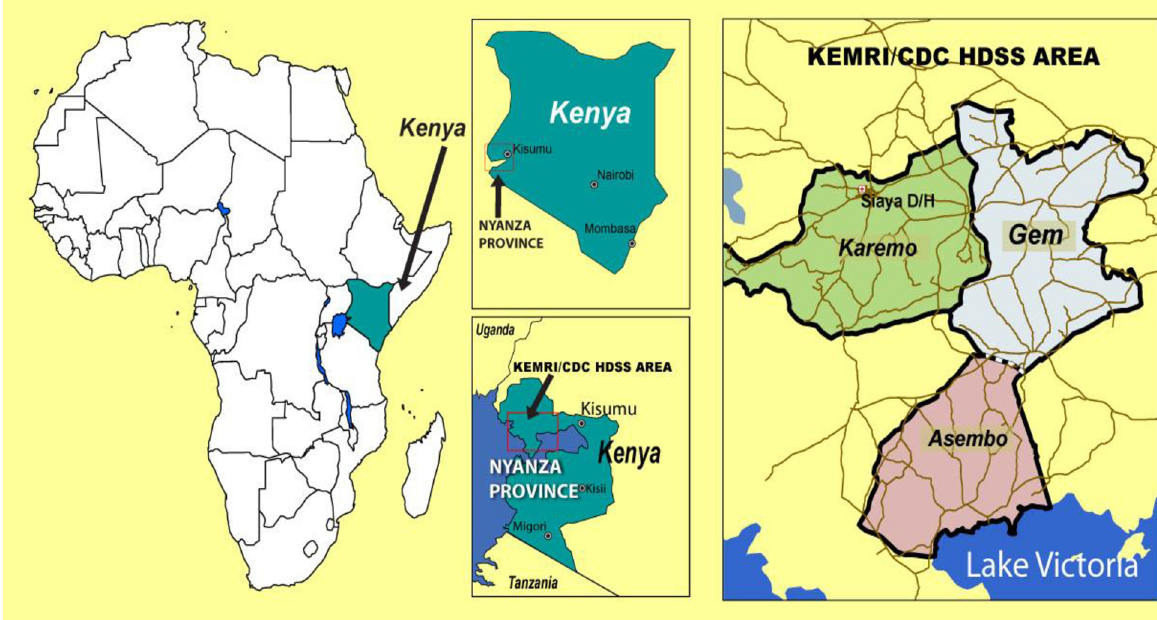
Fig 1. KEMRI/CDC HDSS study area (Asembo, Gem and Karemo) where GEMS Kenya Study was conducted.